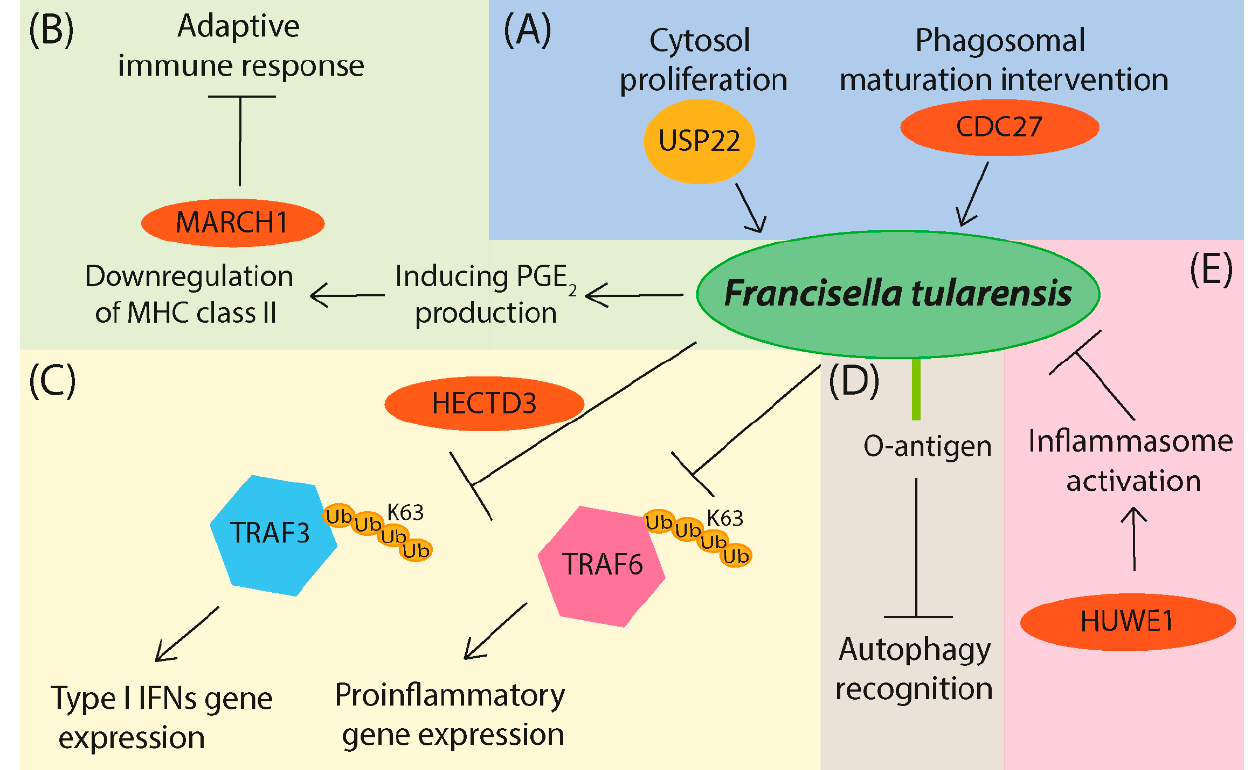
Figure 4. Francisella tularensis manipulation of the host cell ubiquitination system. ( A ) F. tularensis requires host factor DUB USP22 for cytosol proliferation and E3 ligase CDC27 for intervention to phagosomal maturation. ( B ) Adaptive immune response is changed upon induction of host prostaglandine E 2 (PGE 2 ), where the E3 ligase MARCH1 regulates the ubiquitination of MHC class II. ( C ) Innate immune signalization is subverted by changes in the ubiquitination of TRAF3 and TRAF6 adaptors with E3 ligase HECTD3 regulating the K63 polyubiquitination of TRAF3. ( D ) F. tularensis surface O-antigen hinders the autophagy recognition that enables the bacteria proliferation in the cytosol of the host cell. ( E ) Host cell defense mechanism is positively influenced by inflammasome activation through E3 ligase HUWE1.